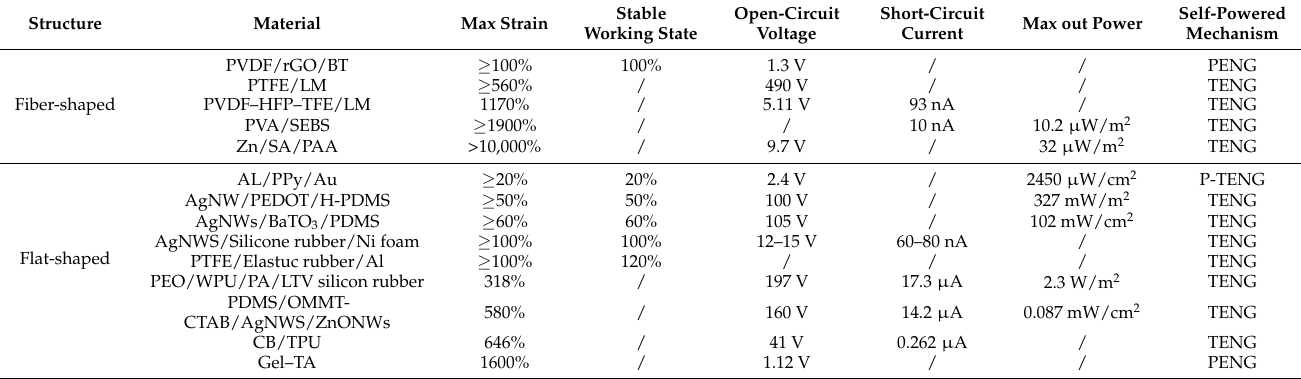
Table 1. Material system and performance of self-powered stretchable flexible sensors with different shapes and structures [41–54].